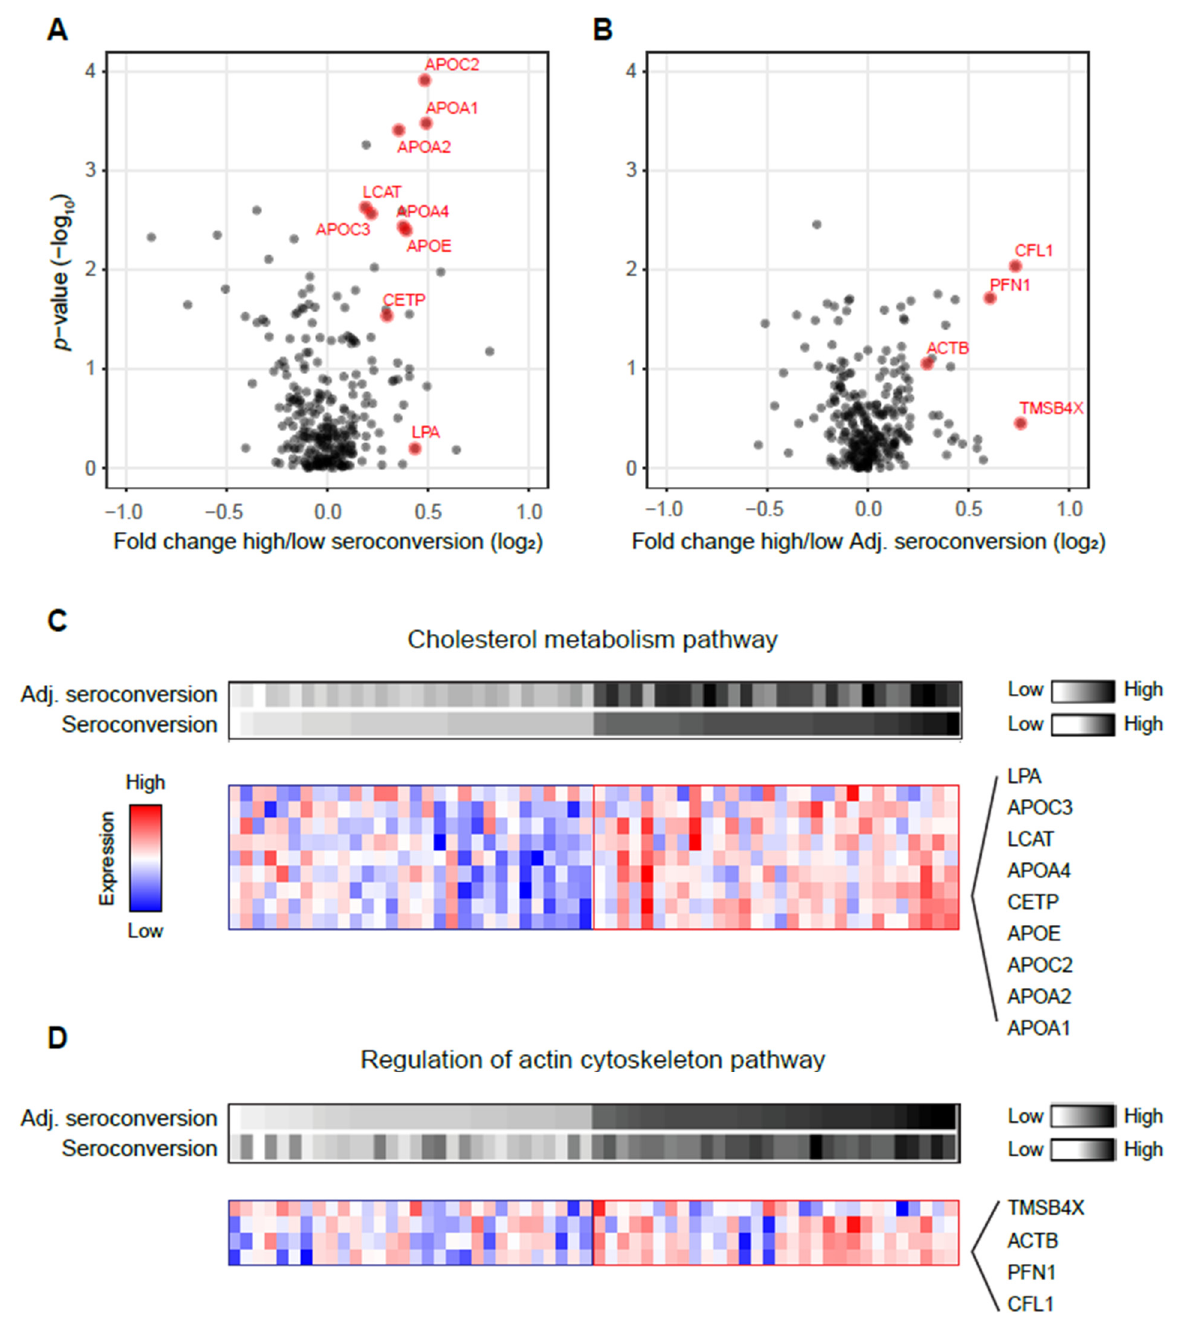
Figure 2. Cholesterol metabolism and regulation of actin cytoskeleton pathways are upregulated in participants with high seroconversion before and after adjusting for confounding factors, respectively. ( A ) Volcano plot showing fold change difference in protein levels and corresponding p -value between participants with the highest and lowest seroconversion. ( B ) Volcano plot showing fold change difference in protein levels and corresponding p -value between participants with the highest and lowest adjusted seroconversion. In both panels, red marks leading proteins from significantly enriched pathways (see Methods). ( C ) Proteins of cholesterol metabolism have higher levels in participants with high seroconversion in response to the influenza vaccine than in participants with low unadjusted seroconversion. ( D ) Genes regulating the actin cytoskeleton have higher levels in participants with high adjusted seroconversion in response to the influenza vaccine than in participants with low seroconversion. Adj. seroconversion, adjusted seroconversion.